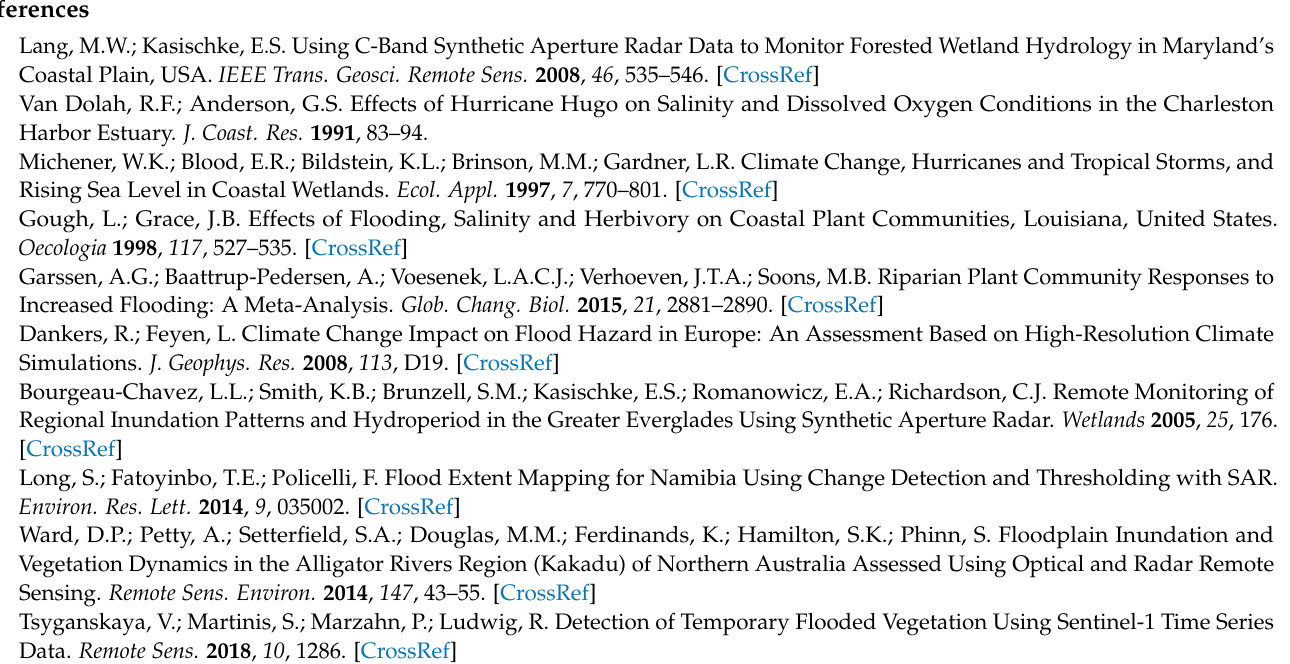
threshold parameters and validation metrics using C-VH data; Table S4. SWDI validation